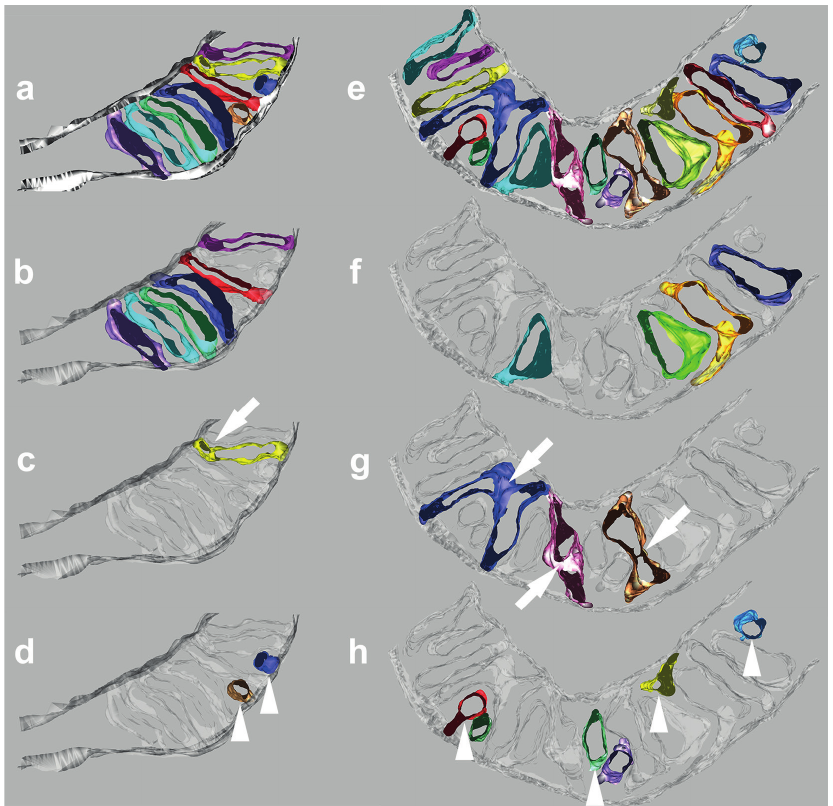
Figure 3 - Mitochondrial cristae alterations induced by VPA. Representative 3-D modeling of mitochondria showed parallel and symmetrical cristae in control cells ( a-c ) with rare small-detached cristae ( d ) (arrowheads), whereas VPA induced morphological alterations such as distensions ( f ), increased number of interconnections ( g ) (arrows) and small- detached cristae ( h )